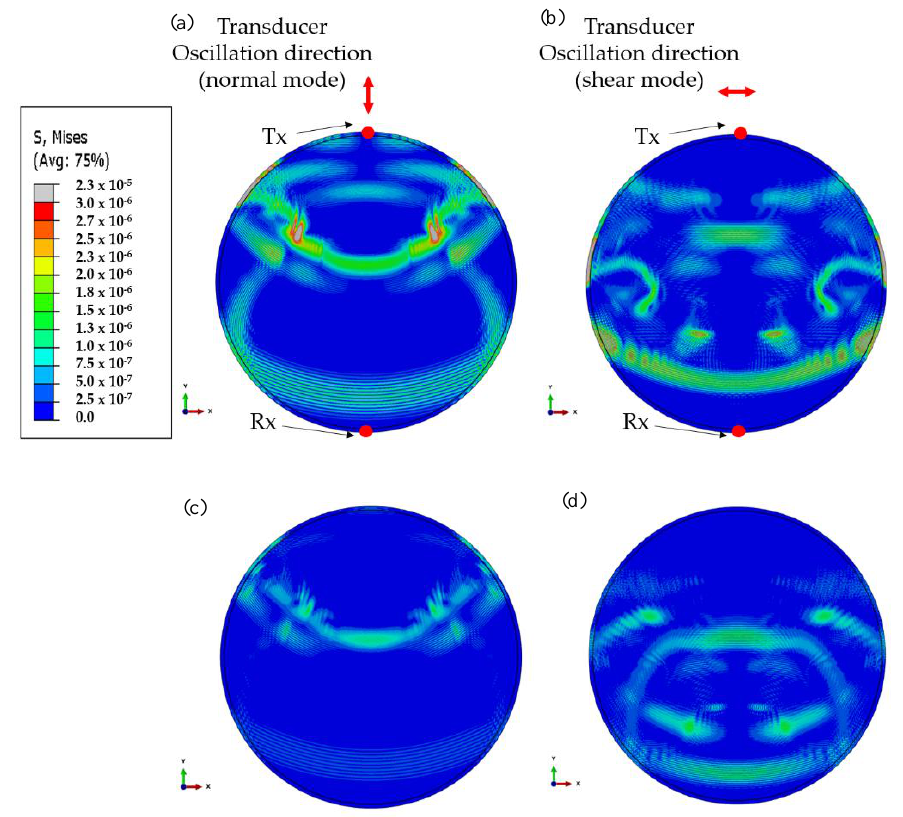
Figure 6. FEA results (Von Mises stress) of ultrasonic guided wave excitation on tank annular chime and tank wall: applied ( a ) normal stress; ( b ) shear stress on tank chime; ( c ) normal stress; and ( d ) shear stress on tank wall.